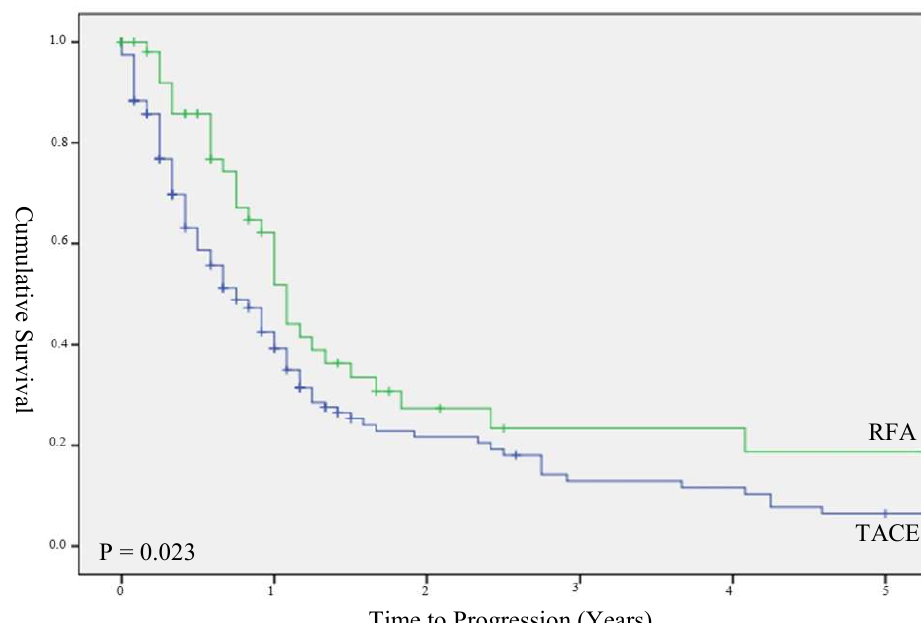
Figure 3. Time to progression in unstratified cohort. Fig. 3 Overall Time to Progression in unstratified cohort Fig. 3 Overall Time to Progression in unstratified cohort